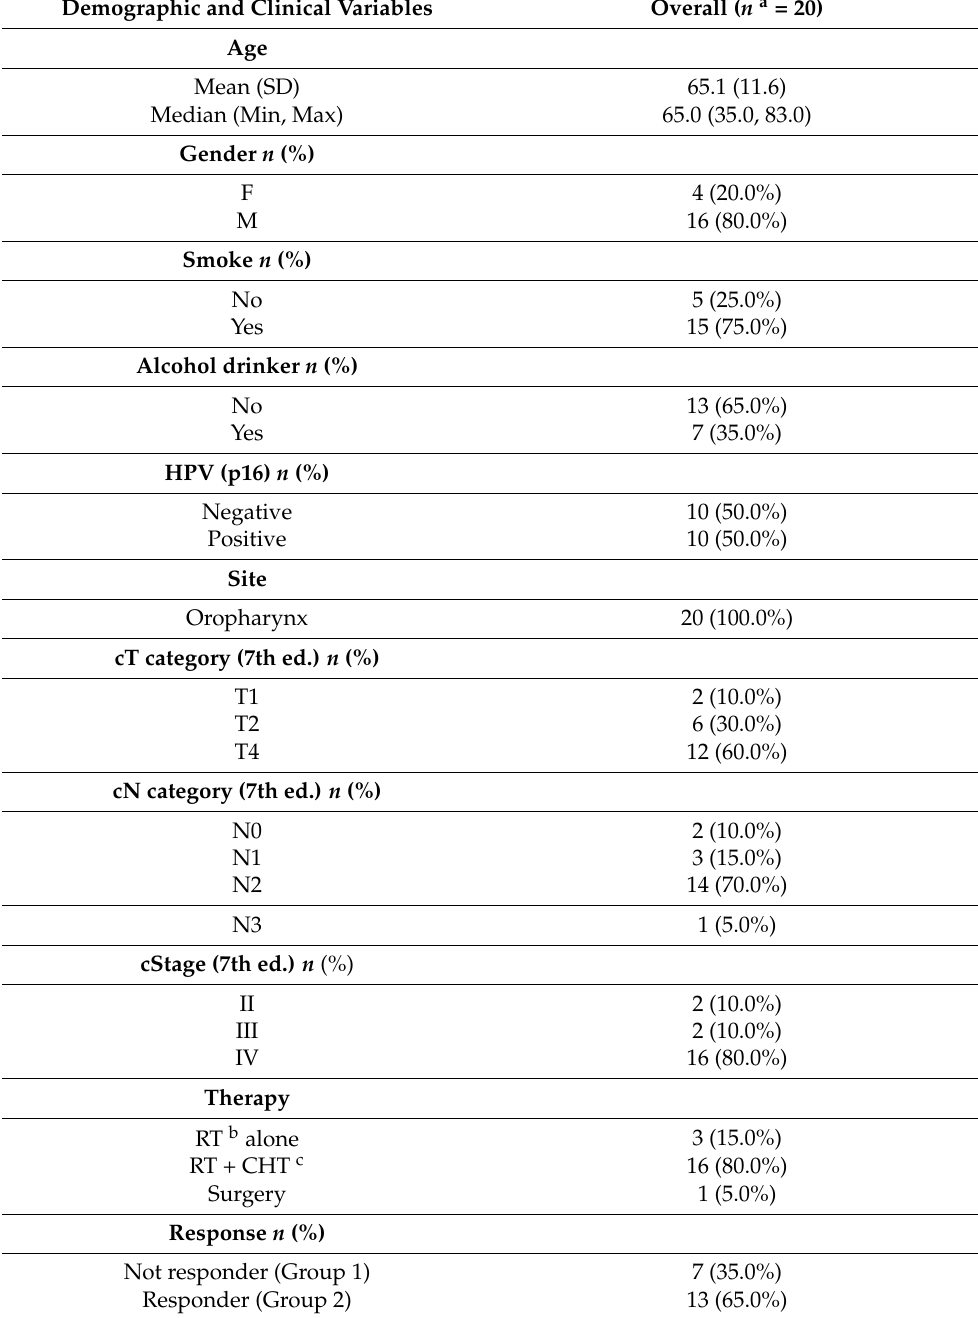
Table 1. Patient